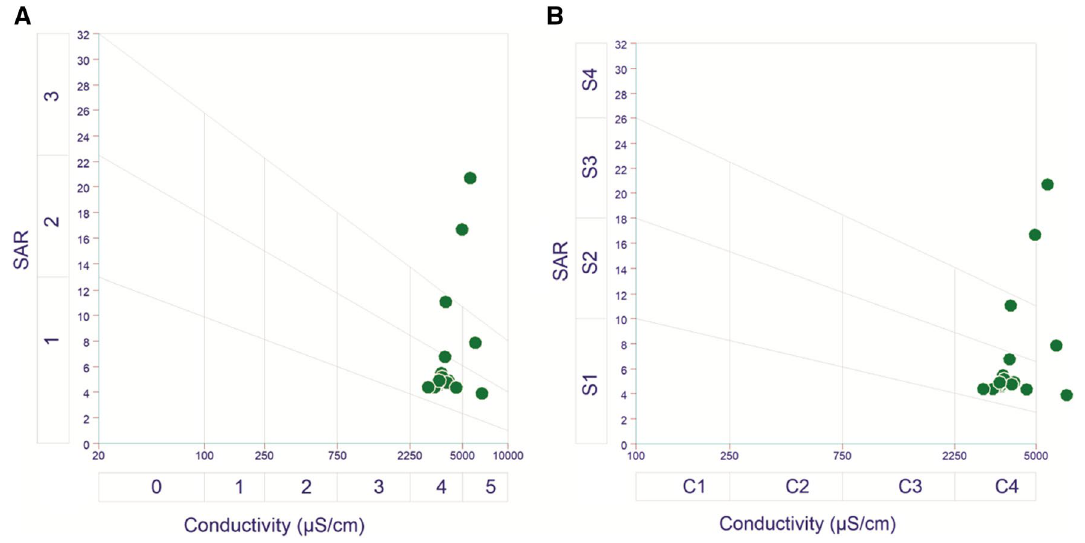
Fig. 4 Distribution of SAR: a Wilcox diagram; b Riverside